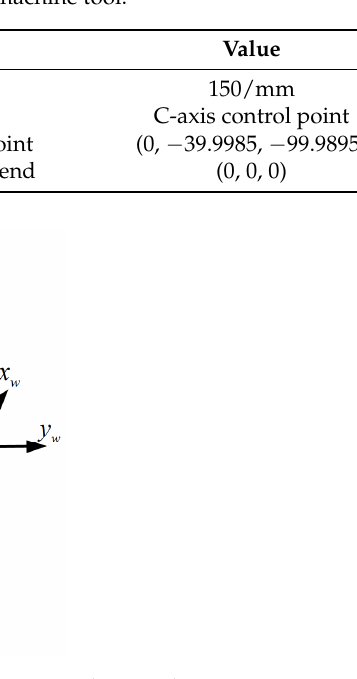
Figure 8. The kinematic chain of the KMC400S U five-axis machine tool. The A-axis control point in Table 2 is a point located on the rotation axis of the A-axis, which is the coordinate origin of the A-axis rotation coordinate system. Similarly, the C-axis control point is a point on the rotation axis of the C-axis, which is the coordinate origin of the C-axis rotation coordinate system. Figure 9 shows the relative position between the C-axis control point and the A-axis control point and the relative position between the C-axis control point and the center of the spindle end. The vector ( x , y , z ) is the vector from A-axis control point to C-axis control point in the initial state of the machine tool, and vector ( u , v , w ) is the vector from C-axis control point to the center of the spindle end in the initial state of the machine tool. Table 2. The PDGEs of X ‐ axis.